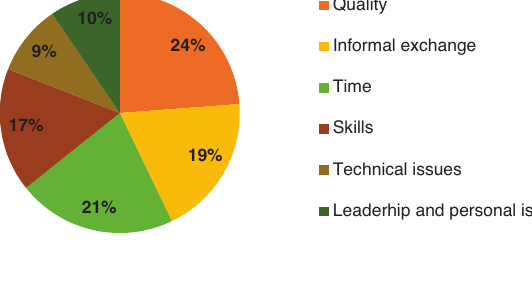
Fig. 5: Challenges of using online tools to